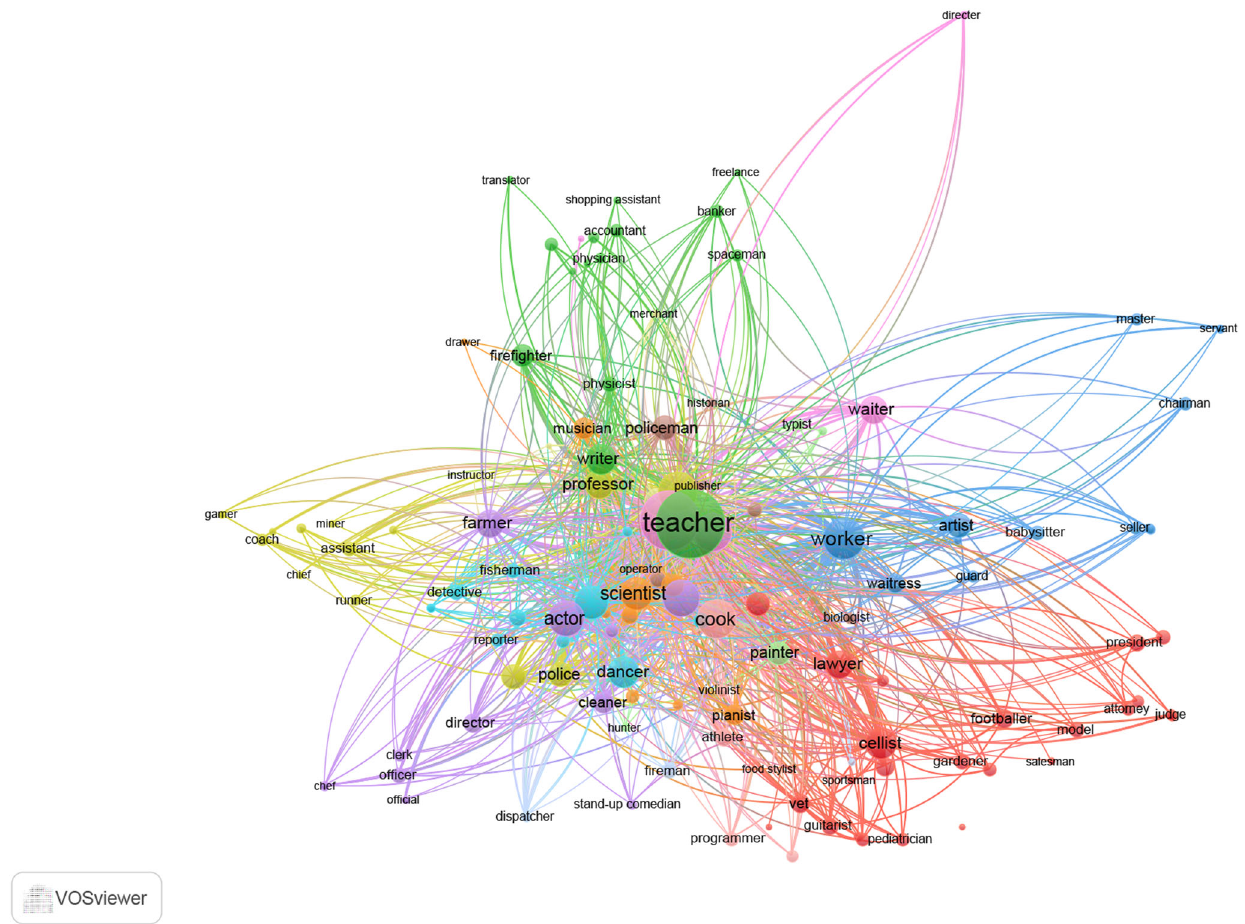
Fig. 1 The L2 lexical-semantic network of the undergraduates. The size of nodes represents the number of links and the color of links signi fi es